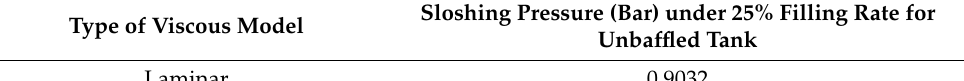
Figure 8. Comparison of mesh sensitivity effect on sloshing pressure in unbaffled rectangular tank under 25% filling ratio.